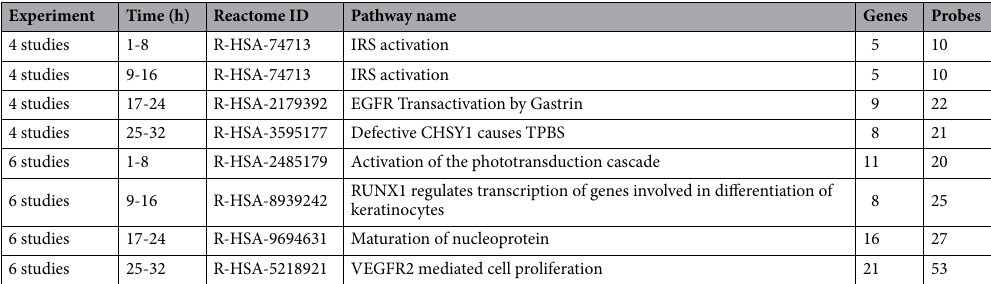
Table 4. The pathways with the highest magnitude SVM weights from CPE for each experiment and time. CPE configurations are pre-computed, directed edges with PageRank centrality. All experiments apply LIMMA using subject identifier to the